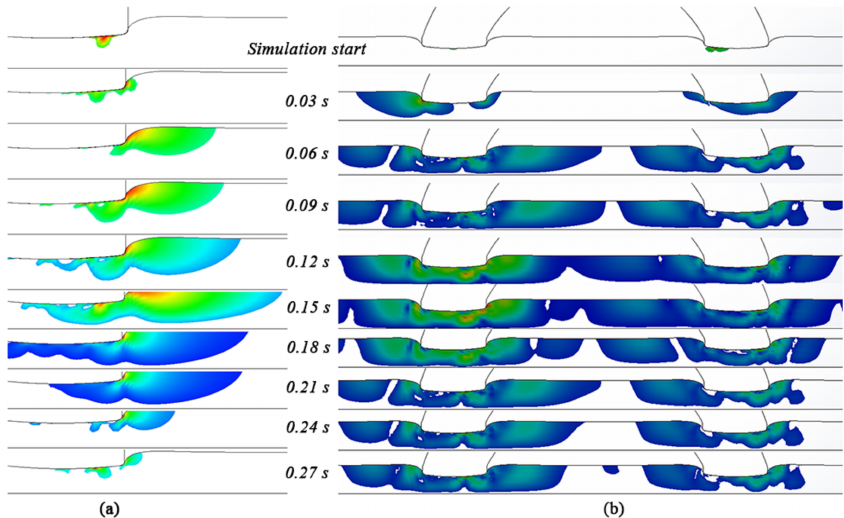
Figure 11. Comparison between the conventional ( a ) and dual-tip ( b ) applicator shockwave velocity and spreading through soft tissue, at a pressure of 6 bar, frequency of 8 Hz, and the time interval between two frames at 0.03